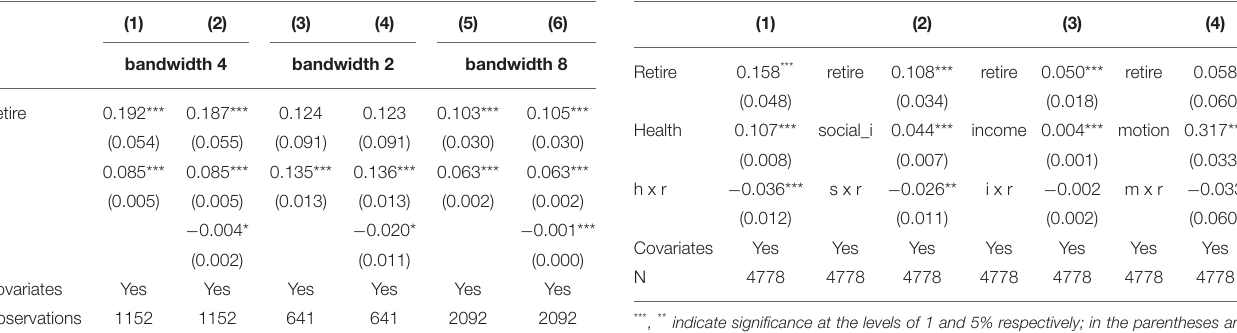
TABLE 7 | The impact of retirement (redefined) on happiness.